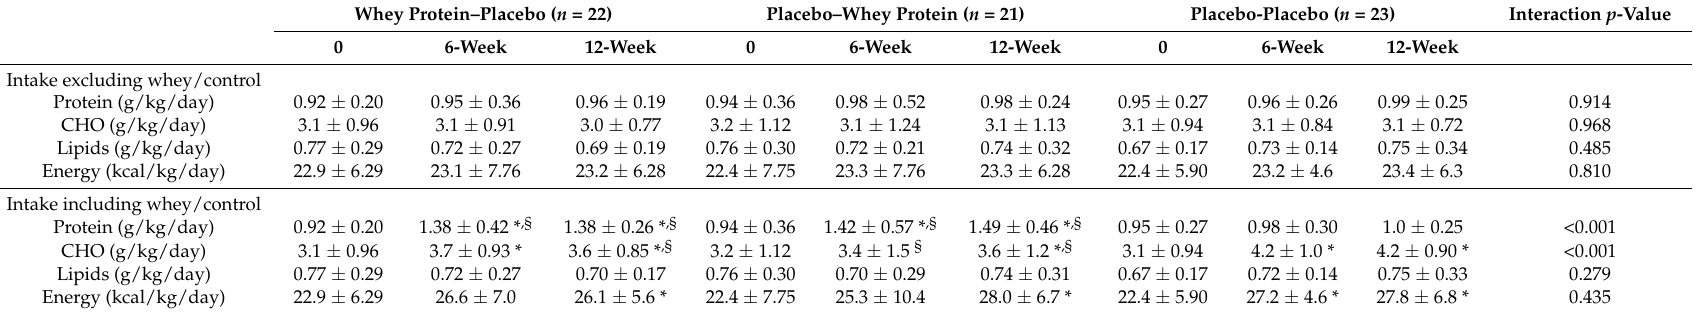
Table 2. Habitual dietary intake of the older women measured at baseline, during, and after 12 weeks of intervention ( n =